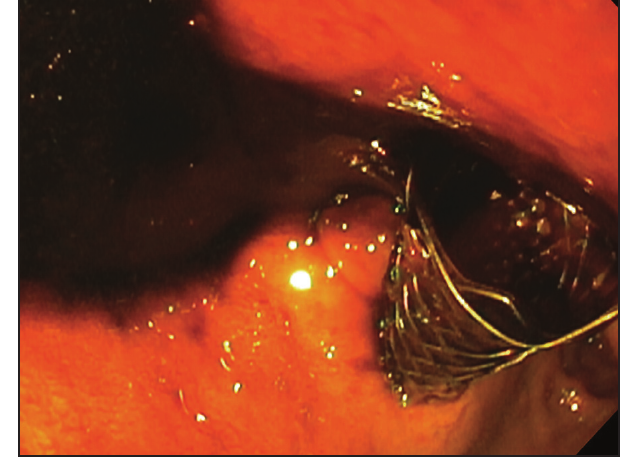
Figure 5) Biliary drainage via covered stent into duodenal bulb Figure 3) Stent deployment with direct endoscopic